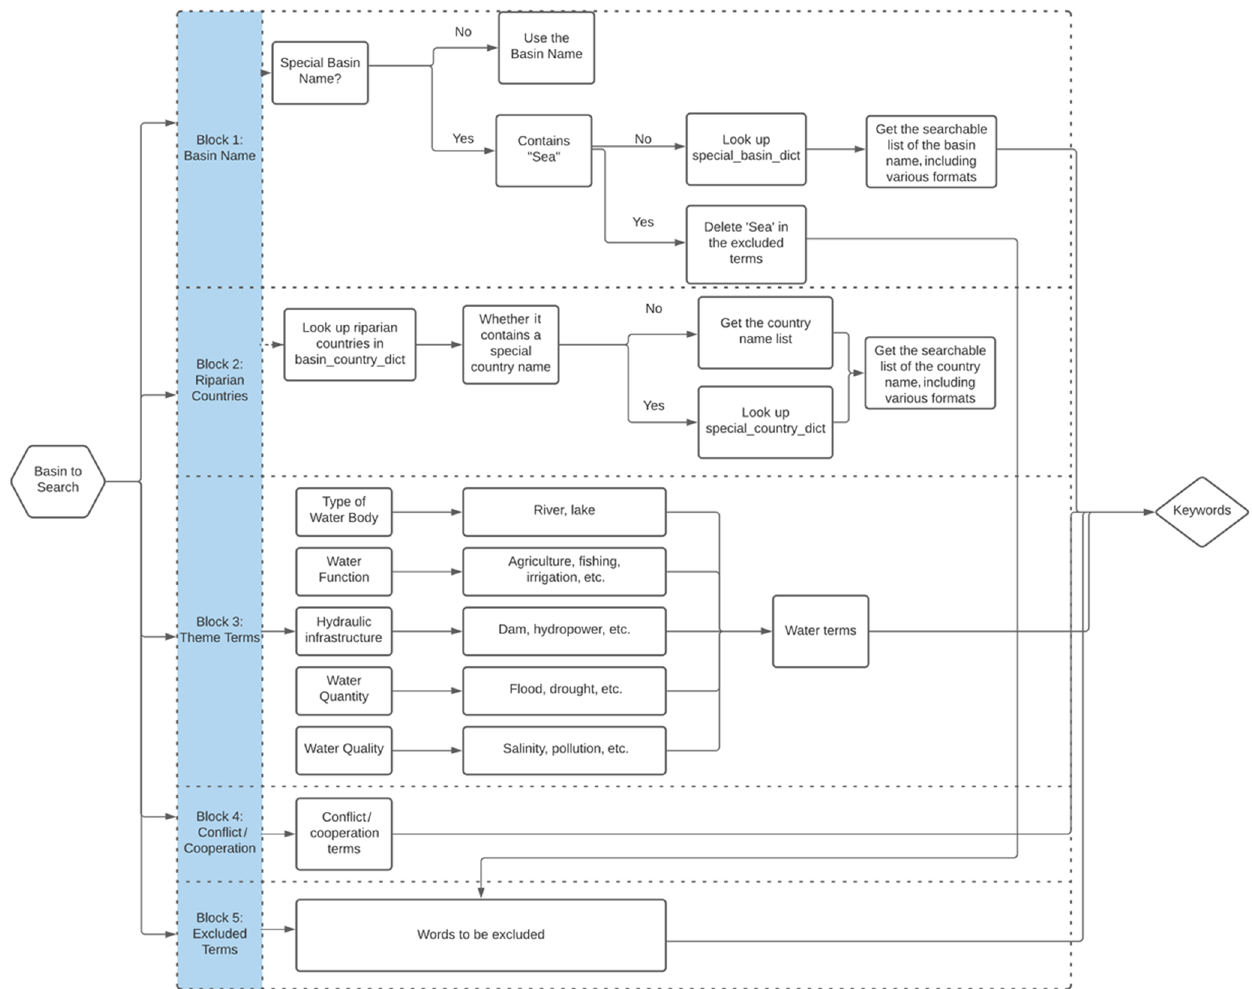
Figure 2. Search keyword generator flow